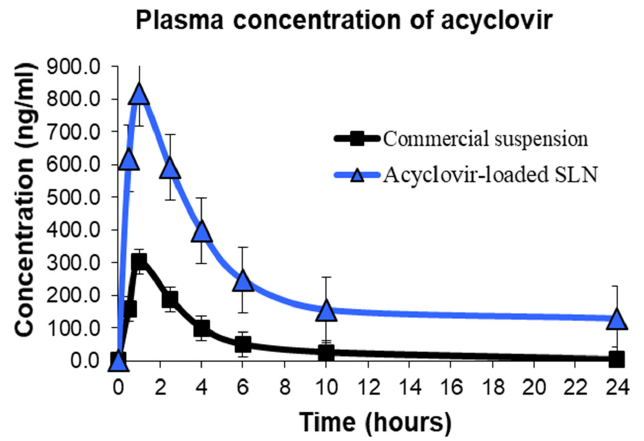
Figure 5. Plasma concentration versus time profile after oral administration of acyclovir-loaded SLN or commercial suspension in rats.